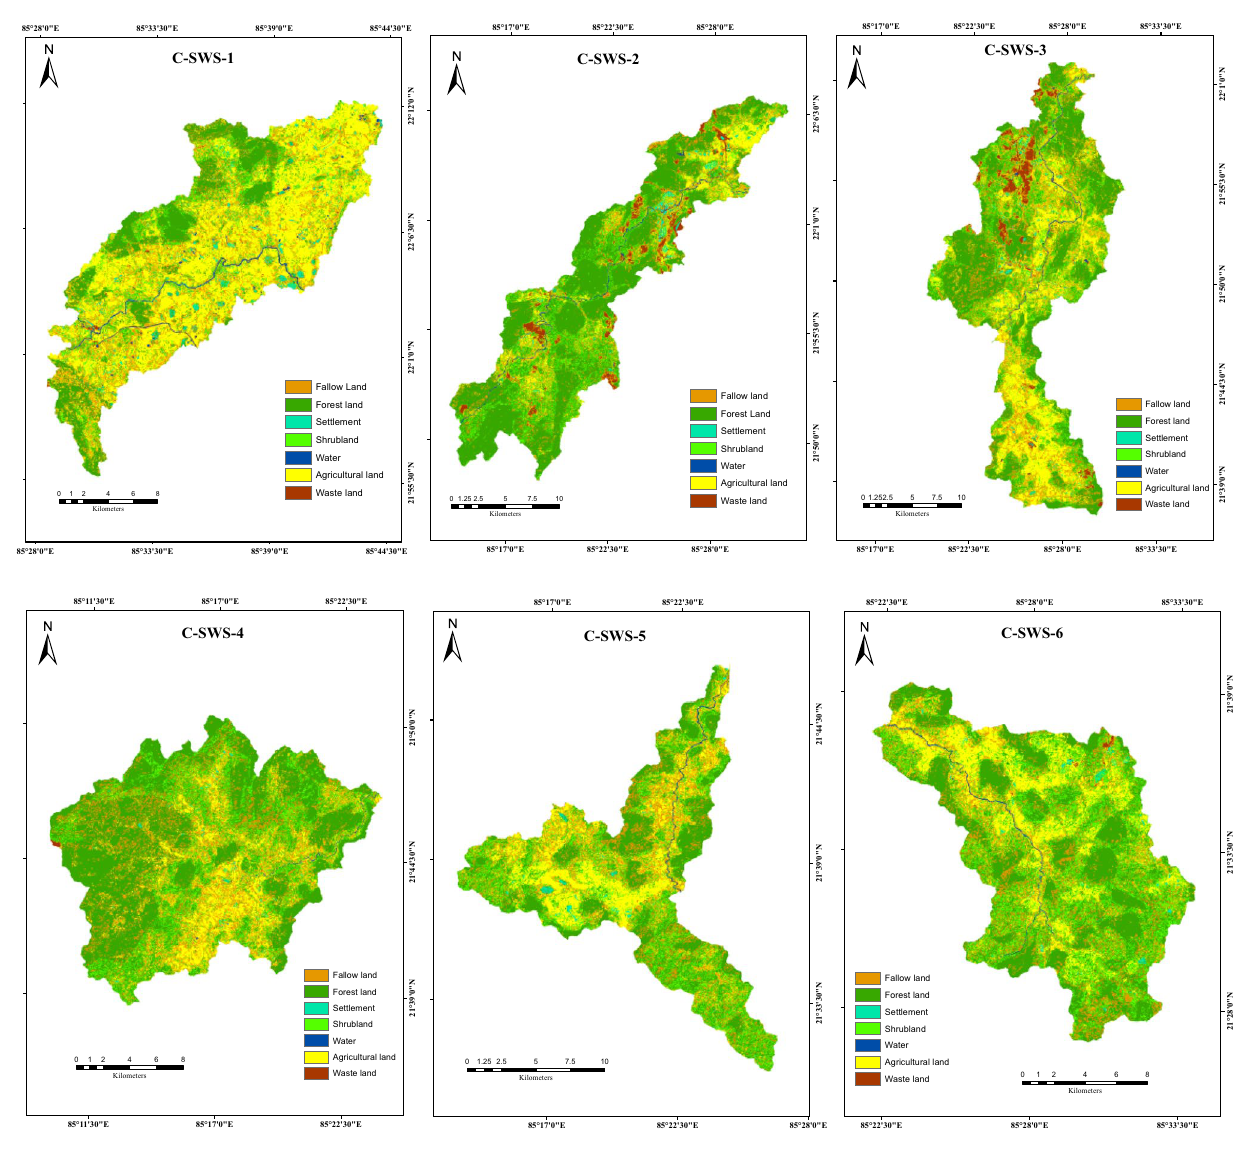
Fig. 7 LULC maps of six sub-watersheds of Champua watershed for the year